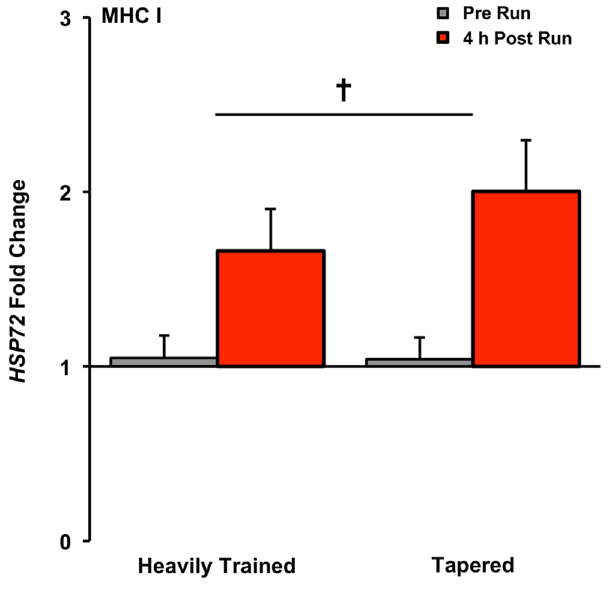
Figure 7. HSP72 gene expression response after an 8 km run in the heavily trained (T1:T2) and tapered (T3:T4) state in MHC I fibers, presented as fold change, Main time effect for exercise, P ,